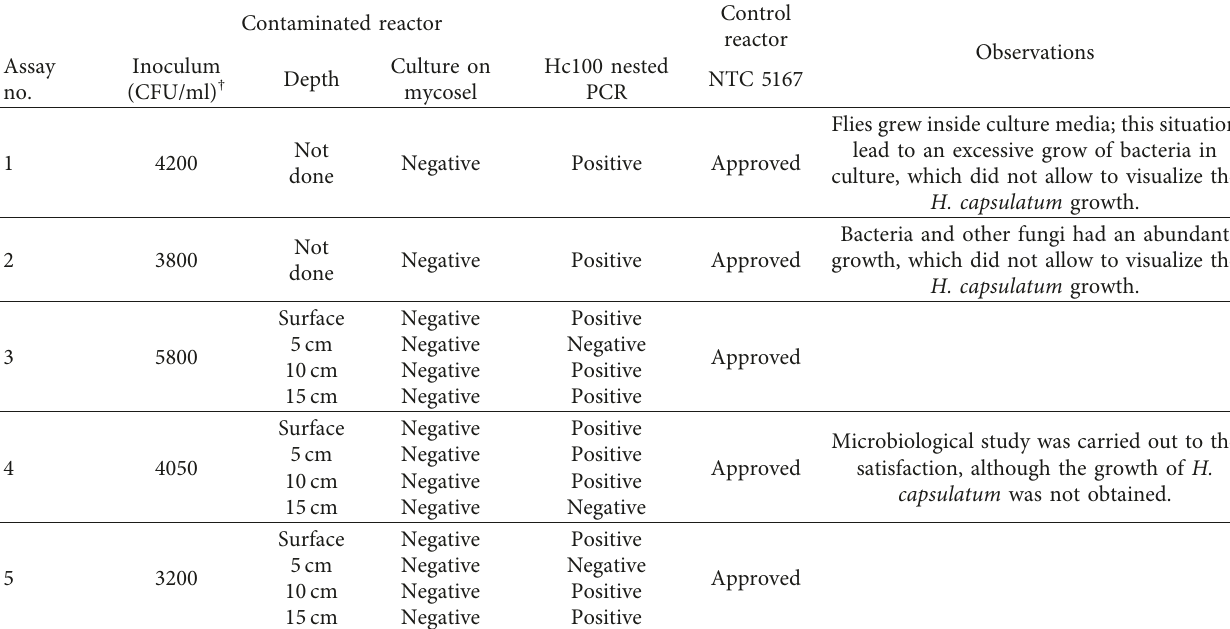
Table 1: Trials of the composting reactors system leading to establish survival of H. capsulatum at the composting process after 45 days.